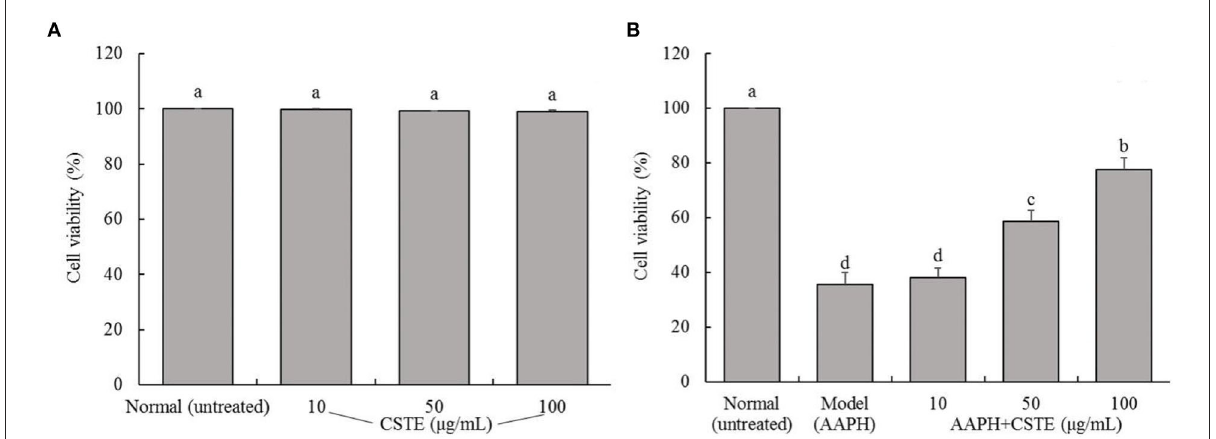
FIGURE2 Survival rate of HL-1 cardiomyocytes, (A) cells not treated with AAPH, (B) AAPH induced oxidative damage of cells; CSTE: Clerodendranthus spicatus (Thunb.) C. Y. Wu extract. a − d according to Duncan’s multi range test, the average values of different letters in the same column have significant differences ( P < 0.05, n =